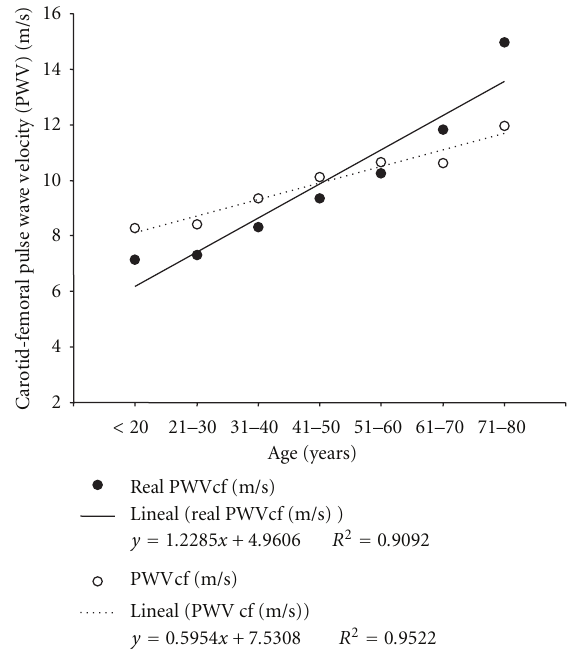
Figure 6: Measured and “real” carotid-femoral pulse wave velocity (PWVcf) age- (decade-) related